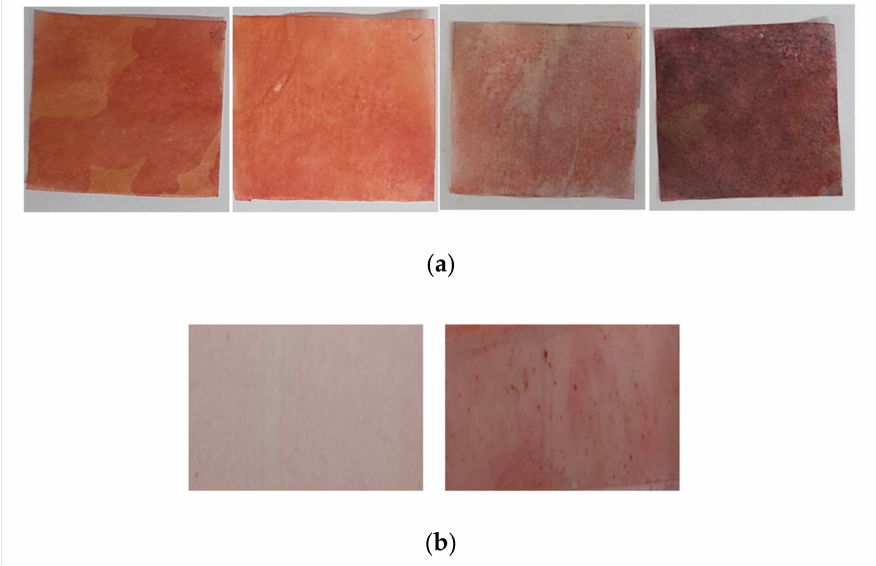
Figure 1. ORO staining test for facial skin sebum collection in commercial oily papers and PVC plastic films. ( a ) ORO staining using four commercial oil blotting papers. ( b ) The left figure presents a plastic film after Oil Red O staining without sebum, while the right figure depicts a plastic film after sebum staining with